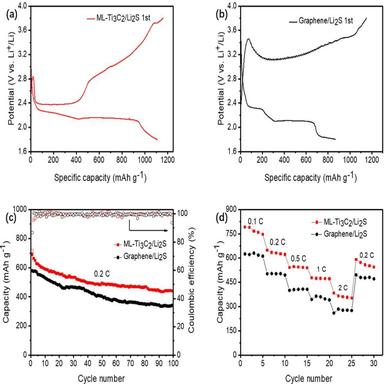
(a) The first charge–discharge profiles for ML-Ti3C2/Li2S cathode at 0.2 C, (b) the first charge–discharge profiles for Graphene/Li2S cathode at 0.2 C, (c) cycling performance and coulombic efficiency of ML-Ti3C2/Li2S and Graphene/Li2S cathodes over 100 cycles at a current rate of 0.2 C, (d) rate performance of ML-Ti3C2/Li2S and Graphene/Li2S cathodes.